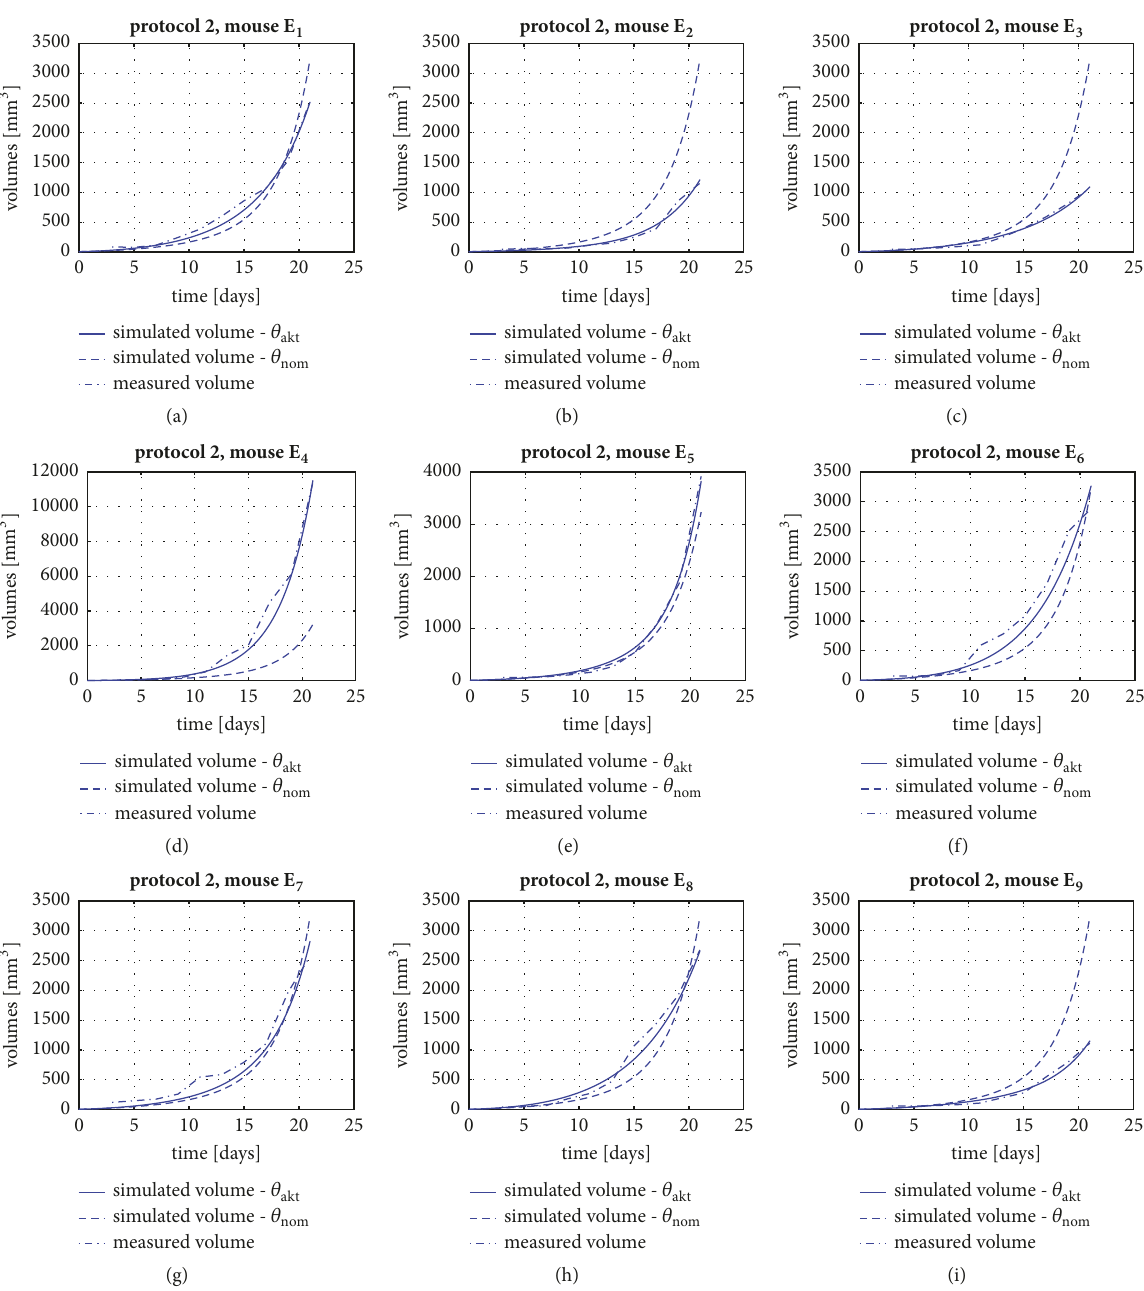
Figure 11: Fitting the model to individual trajectories in the case of therapy 2: simulated output (with the parameters obtained from fitting the model to the specific trajectory ( 𝜃 𝑎𝑘𝑡 ), simulated output with nominal parameters ( 𝜃 𝑛𝑜𝑚 ), and measured